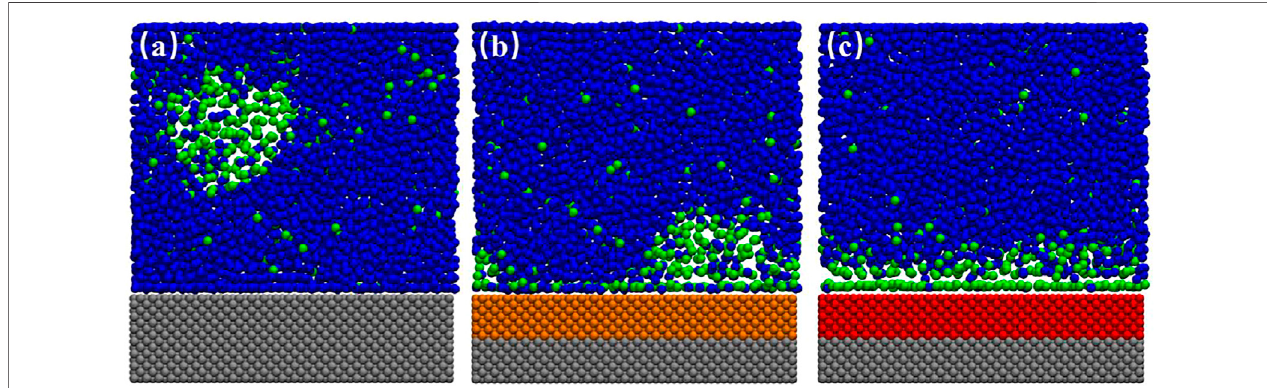
FIGURE 1 | Typical snapshots of the equilibrated box for various substrates. (A) S L , (B) S M , (C) S H . In this case, 300 gas particles and 4,000 liquid particles were randomly fi lled into the simulation box with a typical size of 10.20 × 2.75 × 11.00 nm 3 in x-, y-, and z-direction. The blue and green beads represent the liquid and gas particles, respectively, and the silver, orange, and red beads represent the fi xed solid particles of S L , S M and S H .